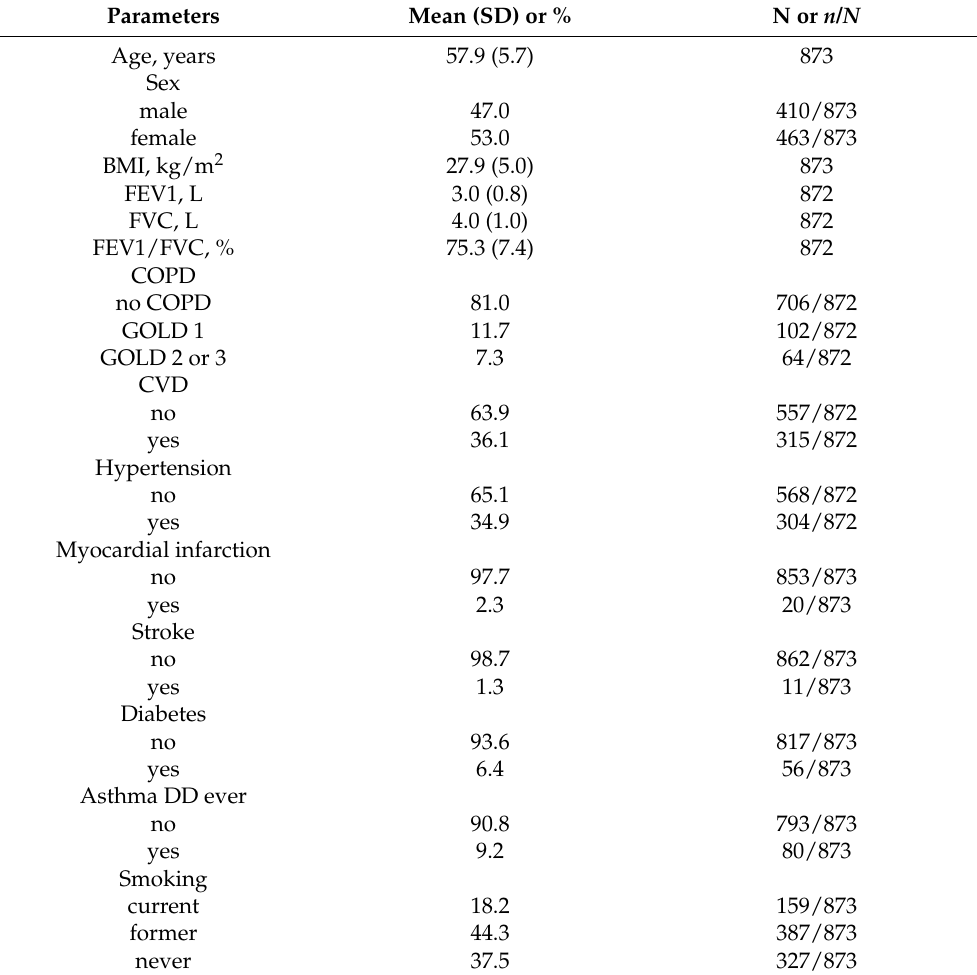
Table 1. Characteristics of the KORA FF4 study